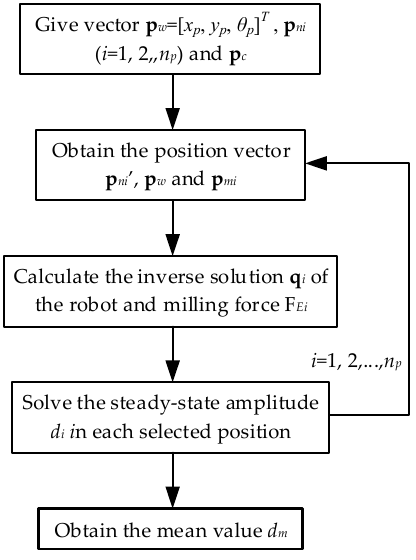
Figure 4. The calculation flow chart of d m .